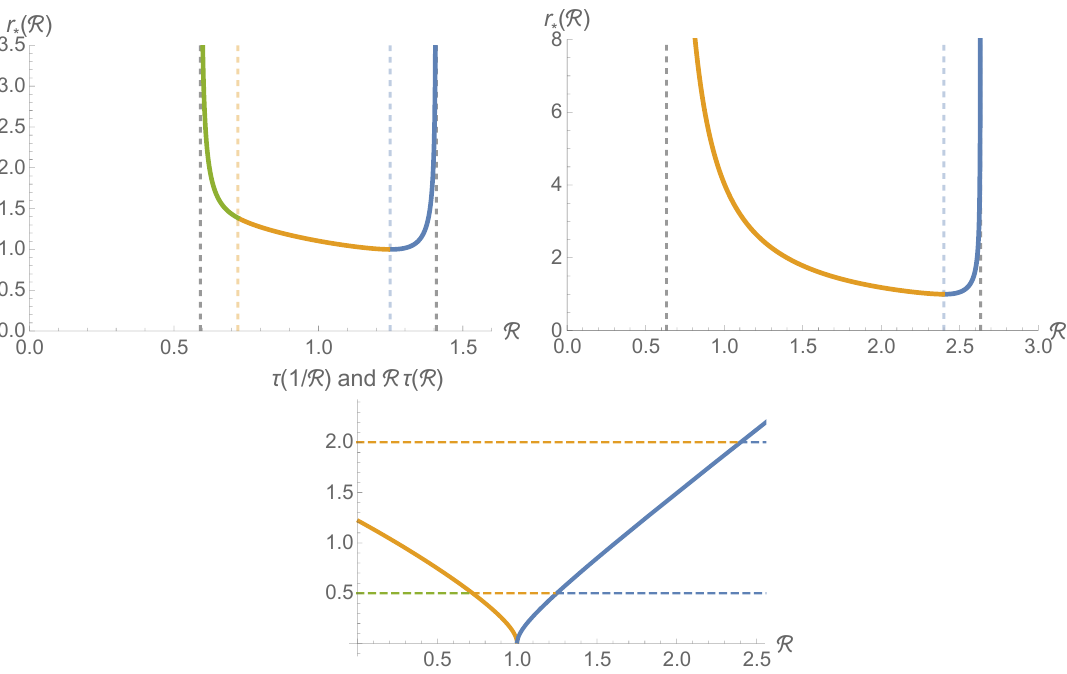
Figure 13. On the (cid:12)rst two (cid:12)gures we plot r (cid:3) ( d = 4 Schwarzschild black brane. The cases (a), (b), and (c) are drawn by blue, orange, and green respectively. The vertical dashed lines indicate the boundaries between the di(cid:11)erent cases, and can be determined by drawing a horizontal line at at = 1 = 2 ; 2 are colored according to the color of the curves in the top row. In more detail, the T left black dashed vertical line is at one at , (cid:12)nally the right black one at v B R 1 ; T